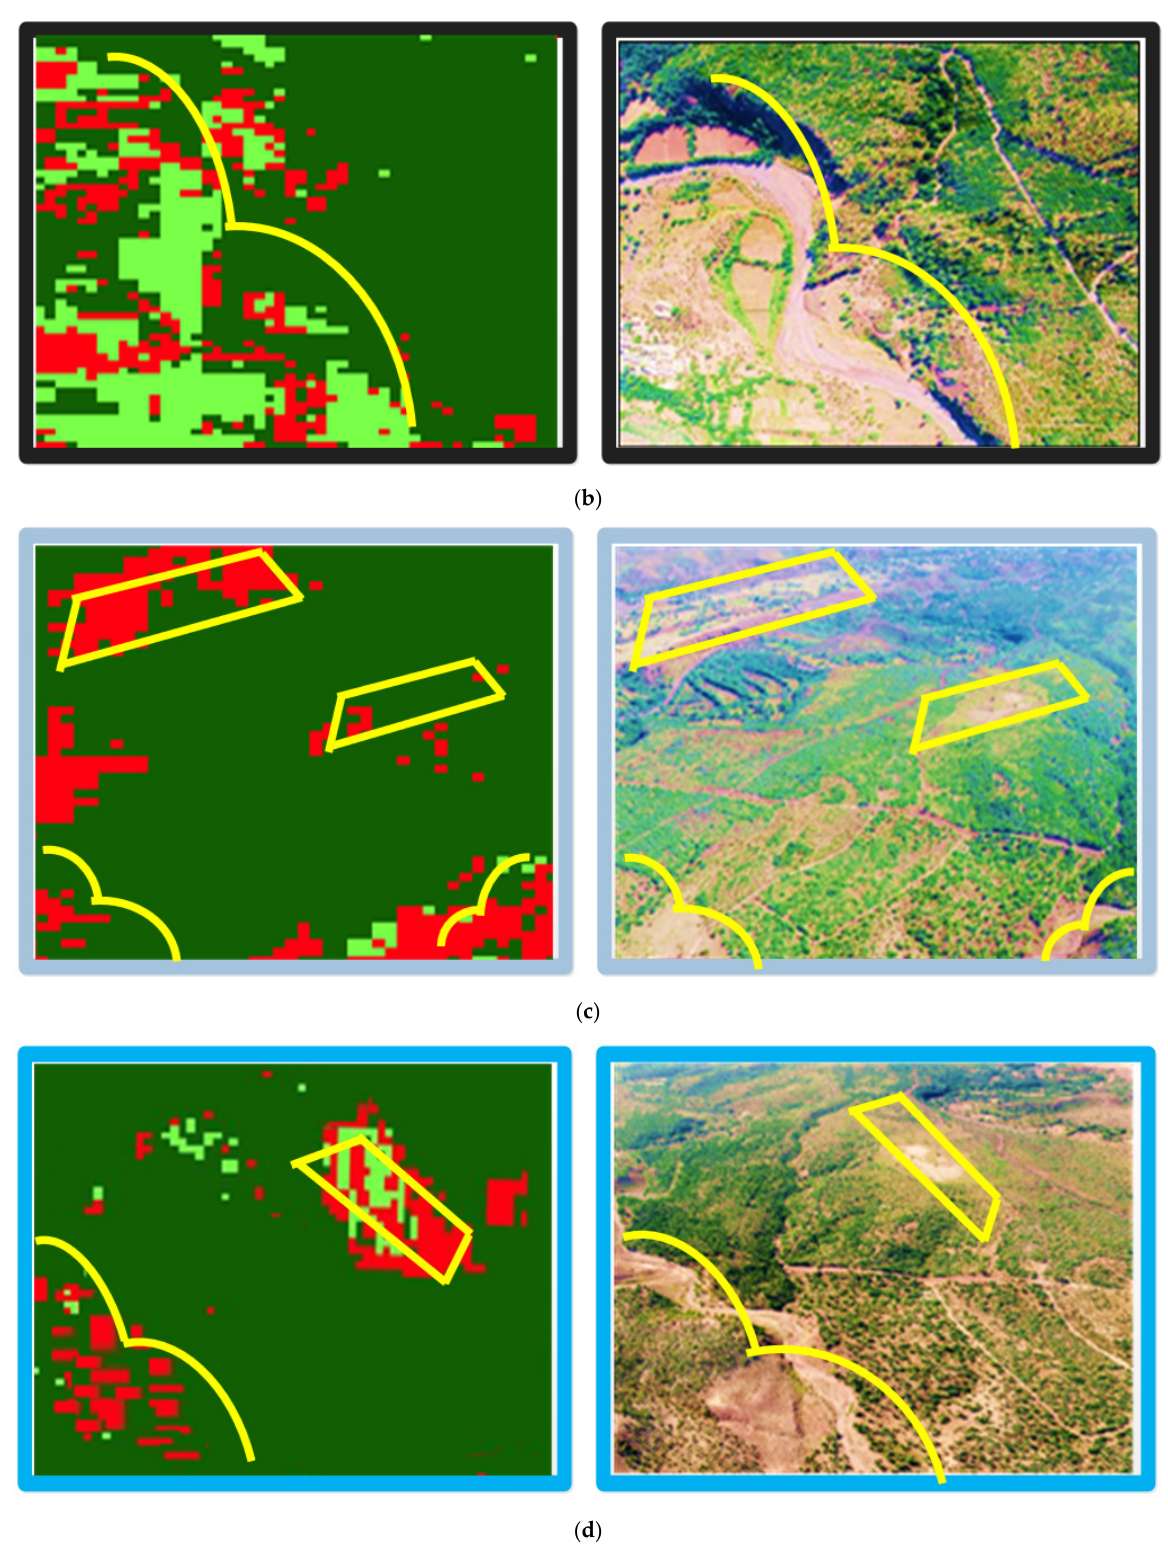
Figure 12. ( a ) Left : classified sub area sample 1, Right : Actual image of sub area sample 1, ( b ) Left : classified sub area sample 2, Right : Actual image of sub area sample 2, ( c ) Left : classified sub area sample 3, Right : Actual image of sub area sample 3, ( d ) Left : classified sub area sample 4, Right : Actual image of sub area sample